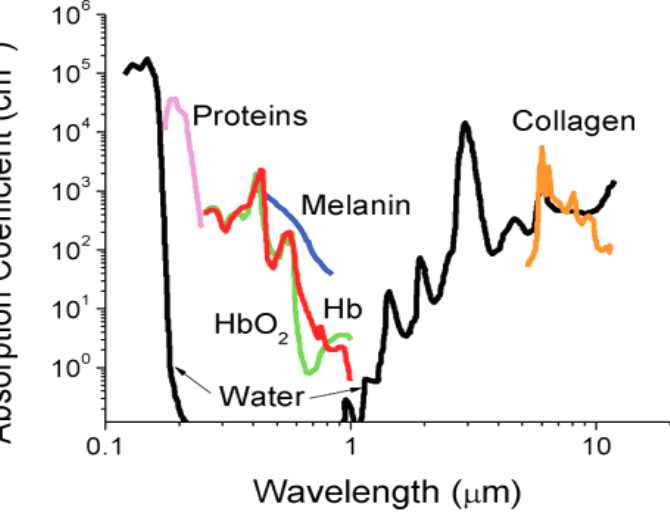
Figure 5. Absorbance of various tissue and blood components from 200 nm to 10 µ m. The optical imaging window ranging from 650 to 1450 nm represents the range where tissue penetration is greatest, HbO 2 and Hb referring to oxygenated and deoxygenated hemoglobin. Reproduced from [97] with permission from ACS, 2012.